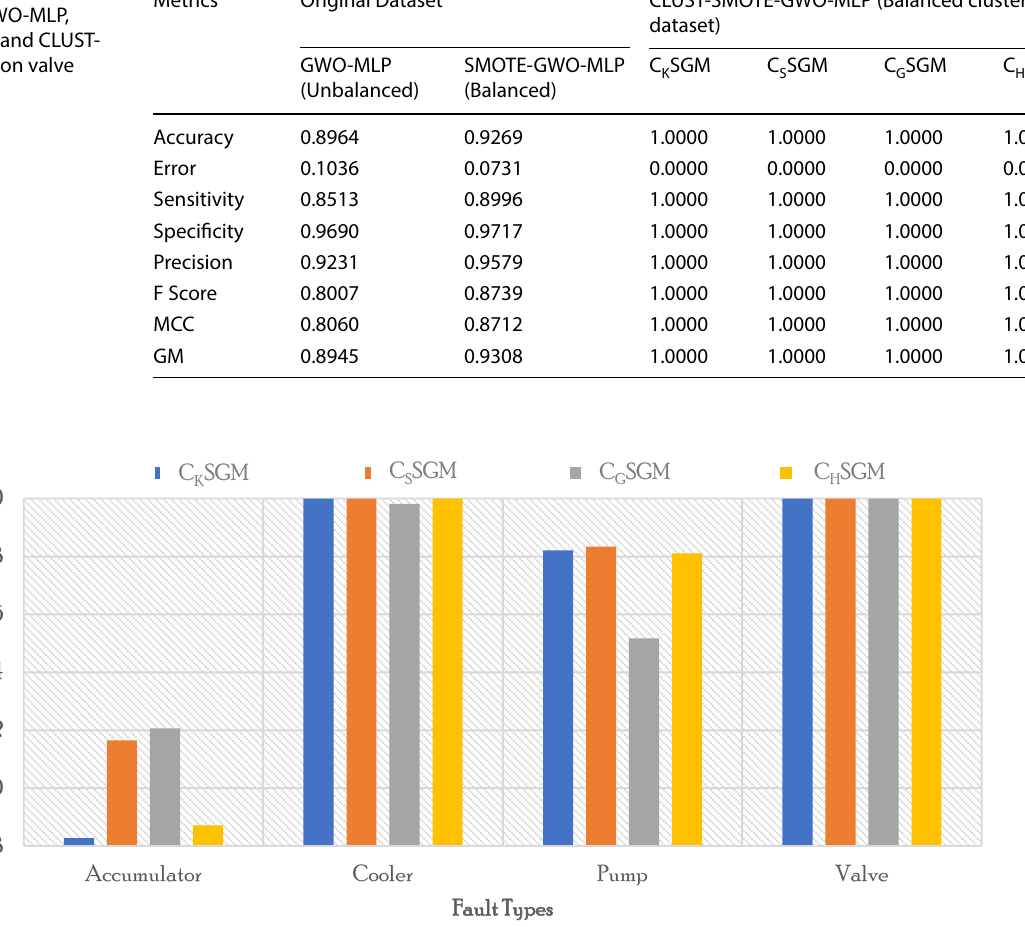
Fig. 5 Contribution of clustering algorithms to CLUST-SMOTE-GWO-MLP fault